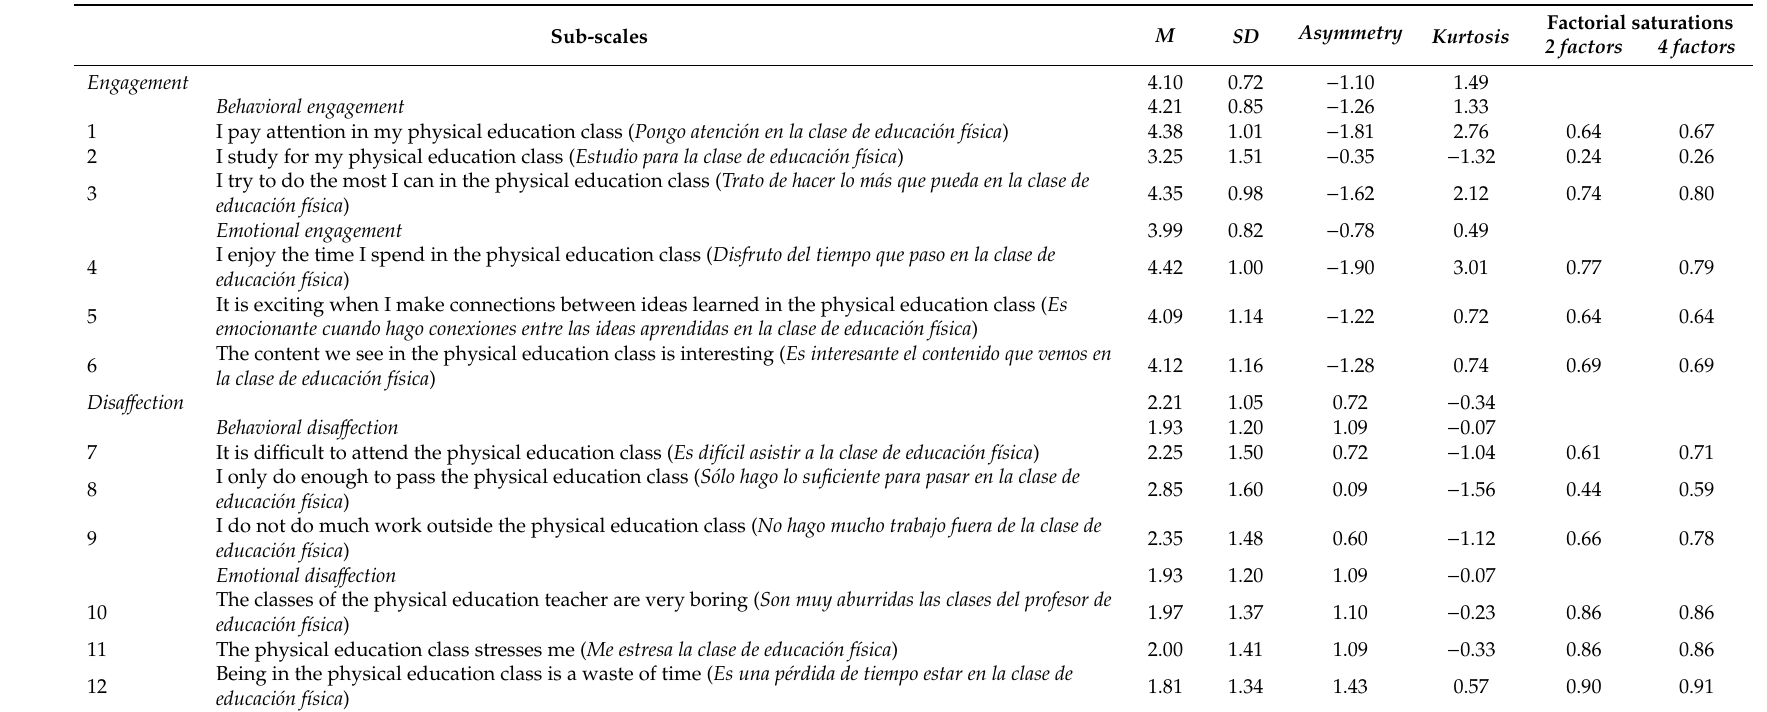
Table 1. The standardized solution of the four sub-scales of the